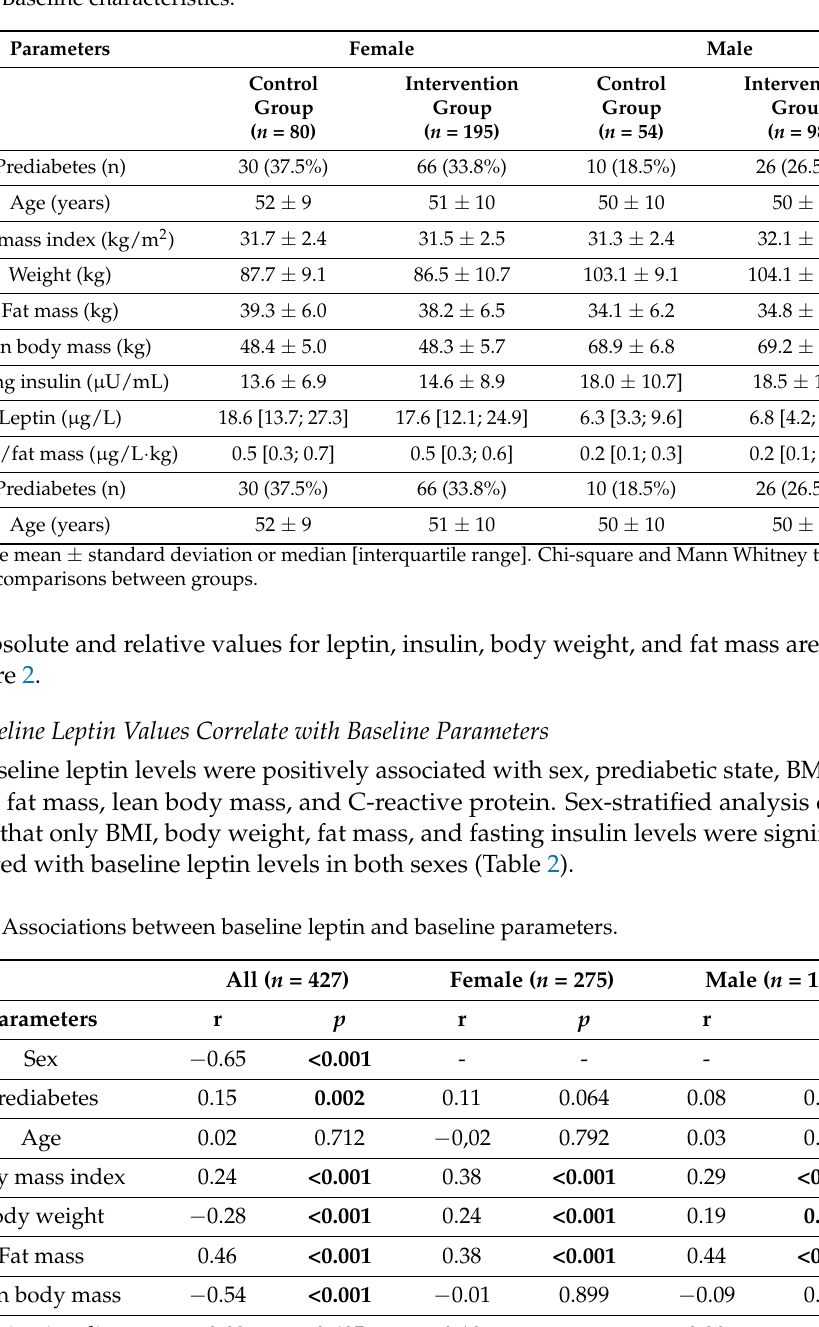
Table 1. Baseline characteristics.